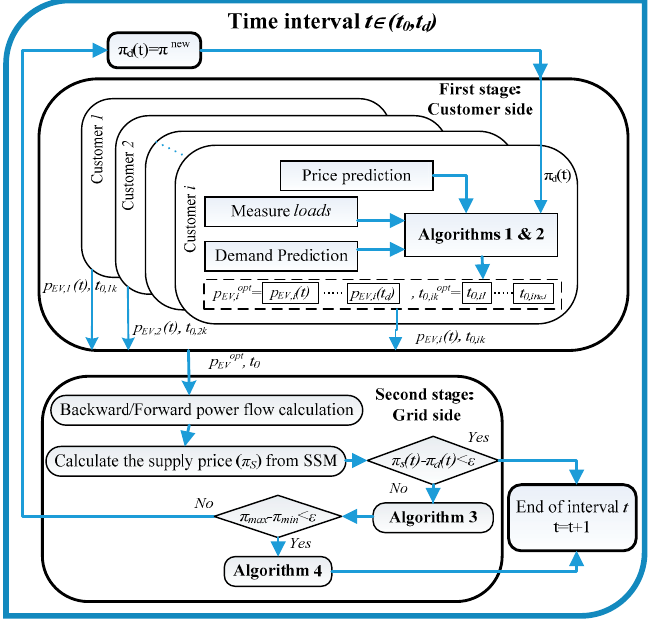
Figure 1. Proposed heuristic two-stage iterative method to solve transactive DSM optimization Figure problem.